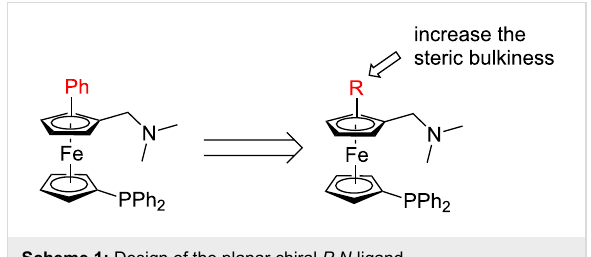
Scheme 1: Design of the planar chiral P , N